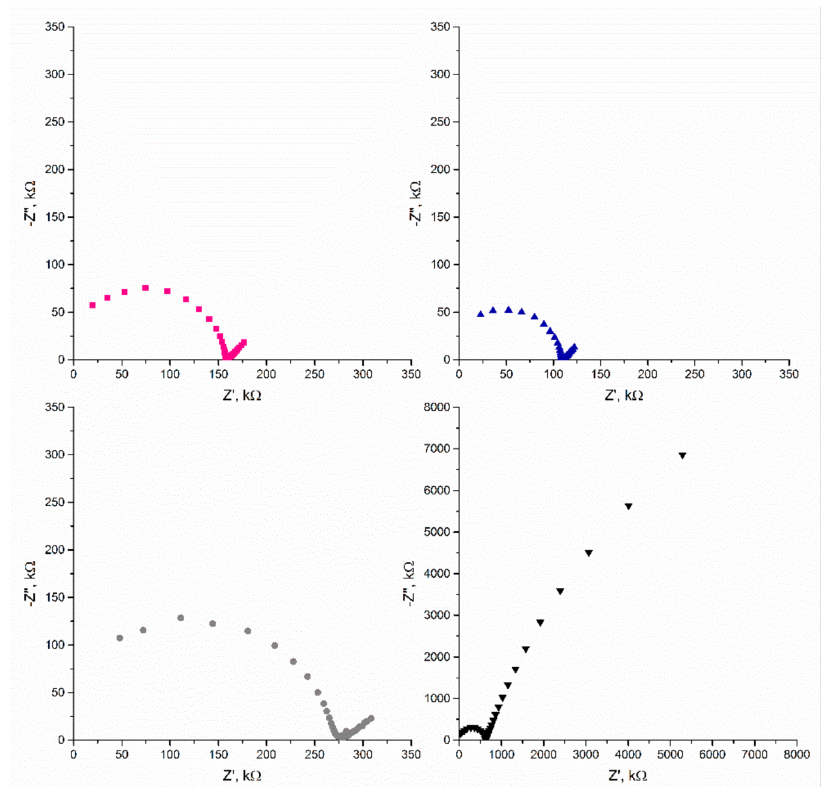
Figure 7. EIS curves of the GC/CB + RuO 2 /K + -ISM ( (cid:4) ), GC/NT + RuO 2 /K + -ISM ( • ), GC/GR + RuO 2 /K + -ISM ( (cid:78) ), and GC/K + -ISM ( (cid:72) )